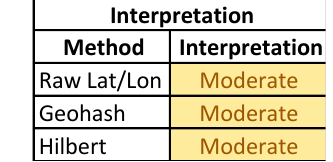
Table 6. Ease of Interpretation Comparison